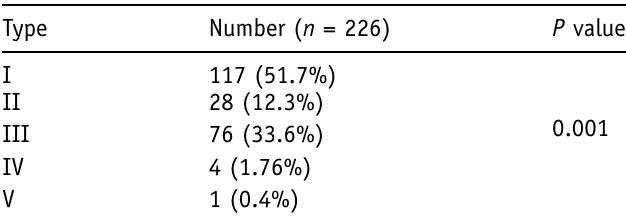
Table IV. Lesions based on Magro and Crowson classi fi cation.